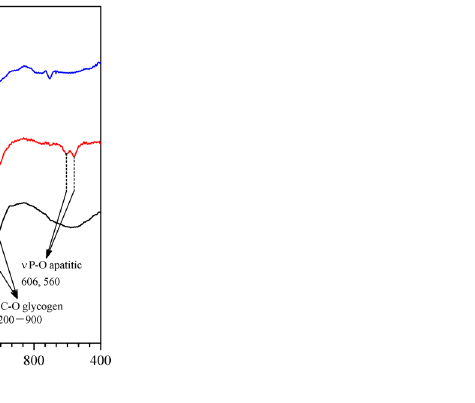
Figure 2. FTIR spectra of the CM-0, CM-2 and